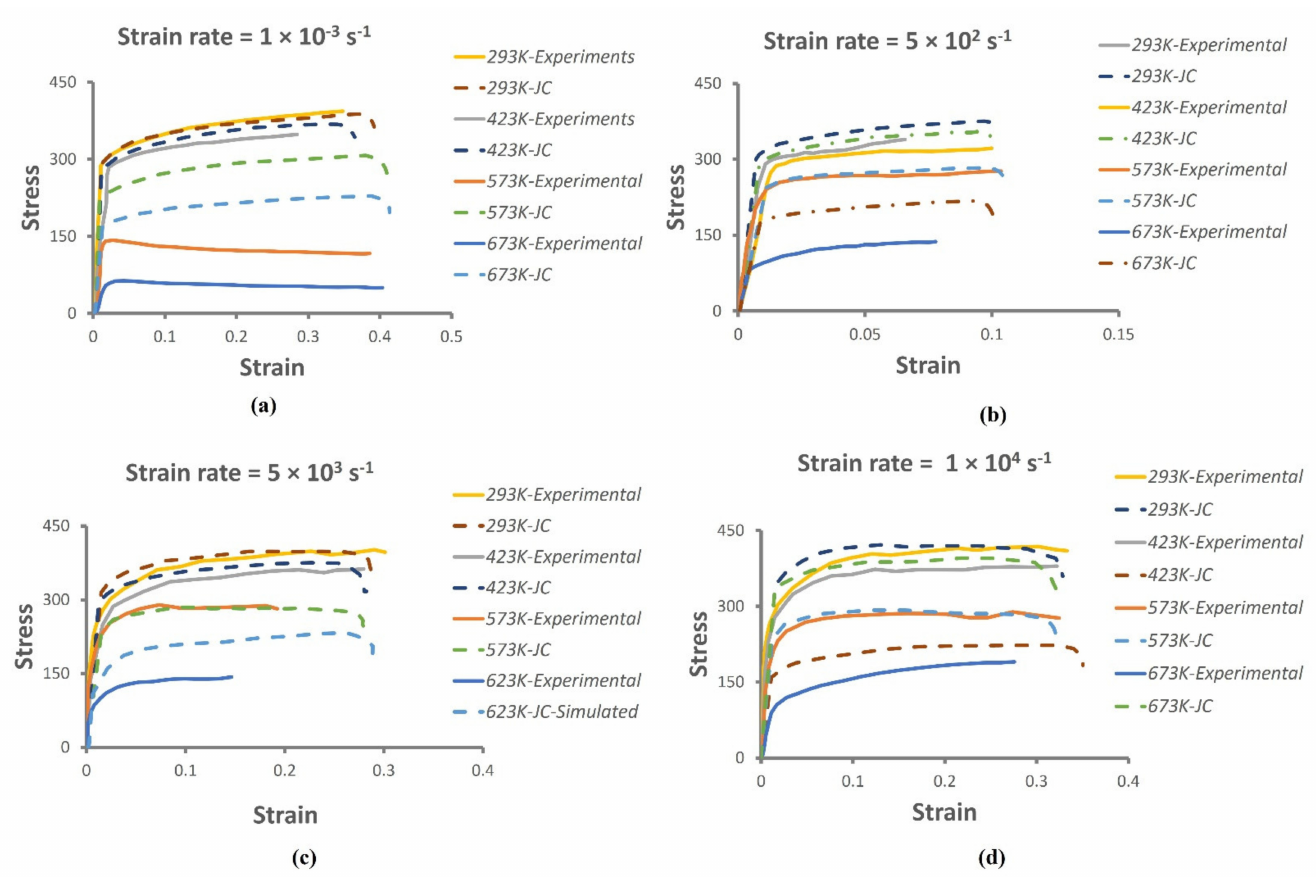
Figure 8. Experimental and simulated stress–strain curve of Al 6061-T6 at strain rate of ( a ) 1 × 10 − 3 s − 1 ( b ) 5 × 10 2 s − 1 ( c ) 5 × 10 3 s − 1 ( d ) 1 × 10 4 s − 1 .